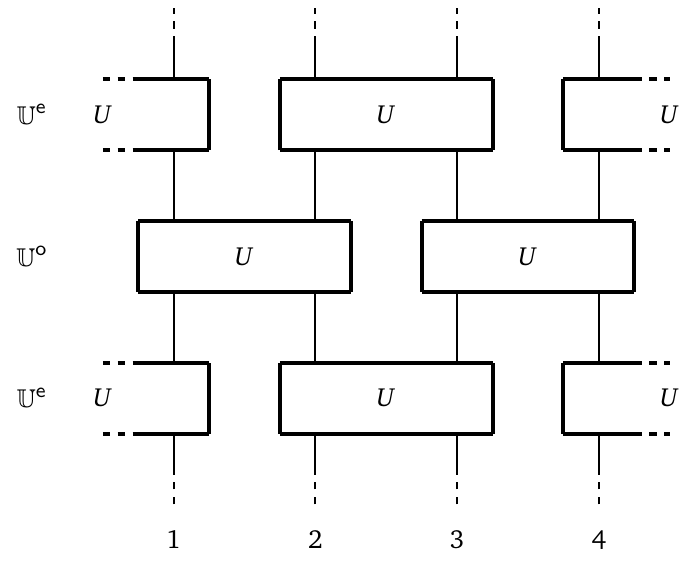
Figure 1: Pictorial representation of the discrete time dynamics for periodic boundary conditions. Note that the time flows